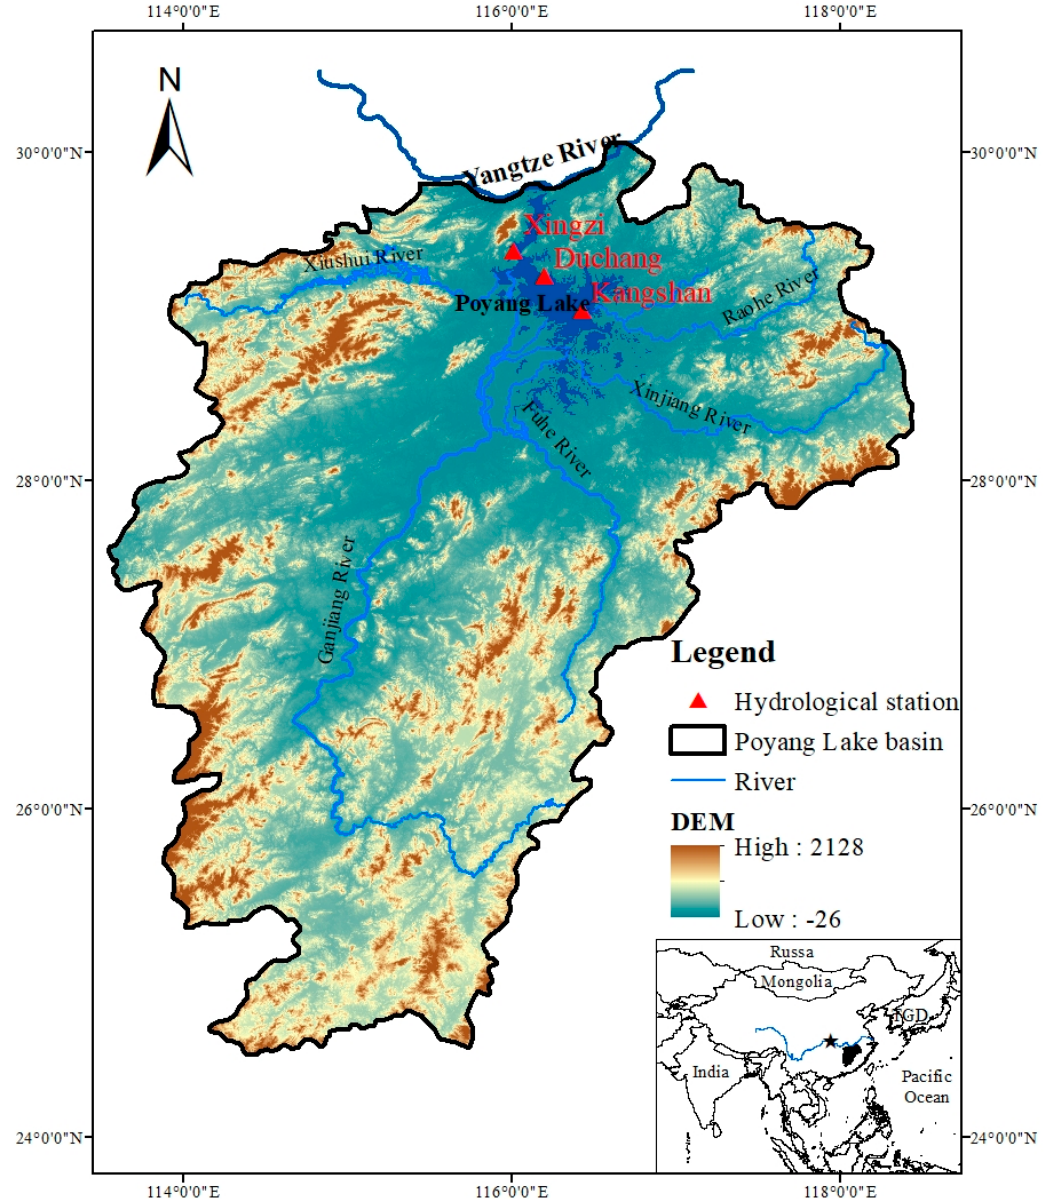
Figure 1. Location of Poyang Lake and Xingzi, Duchang, and Kangshan Stations.